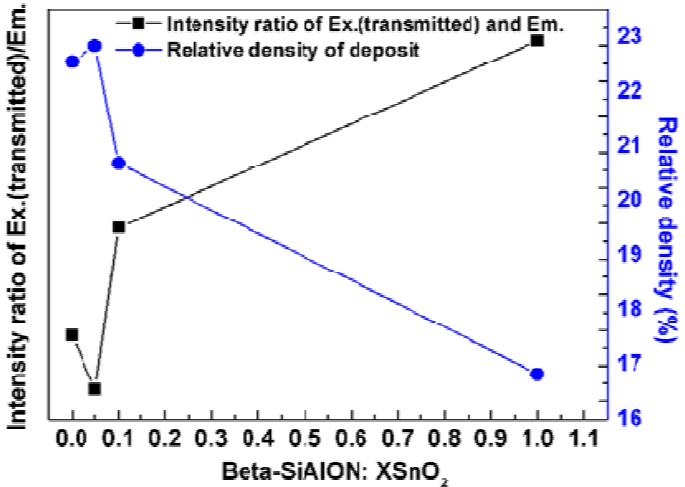
Figure 6. Intensity ratio of the transmitted excitation and emission of the deposit as a function of its relative density by varying the mixing amount of the SnO of the transmitted excitation and emission were obtained from the PL spectra (Figure 5).